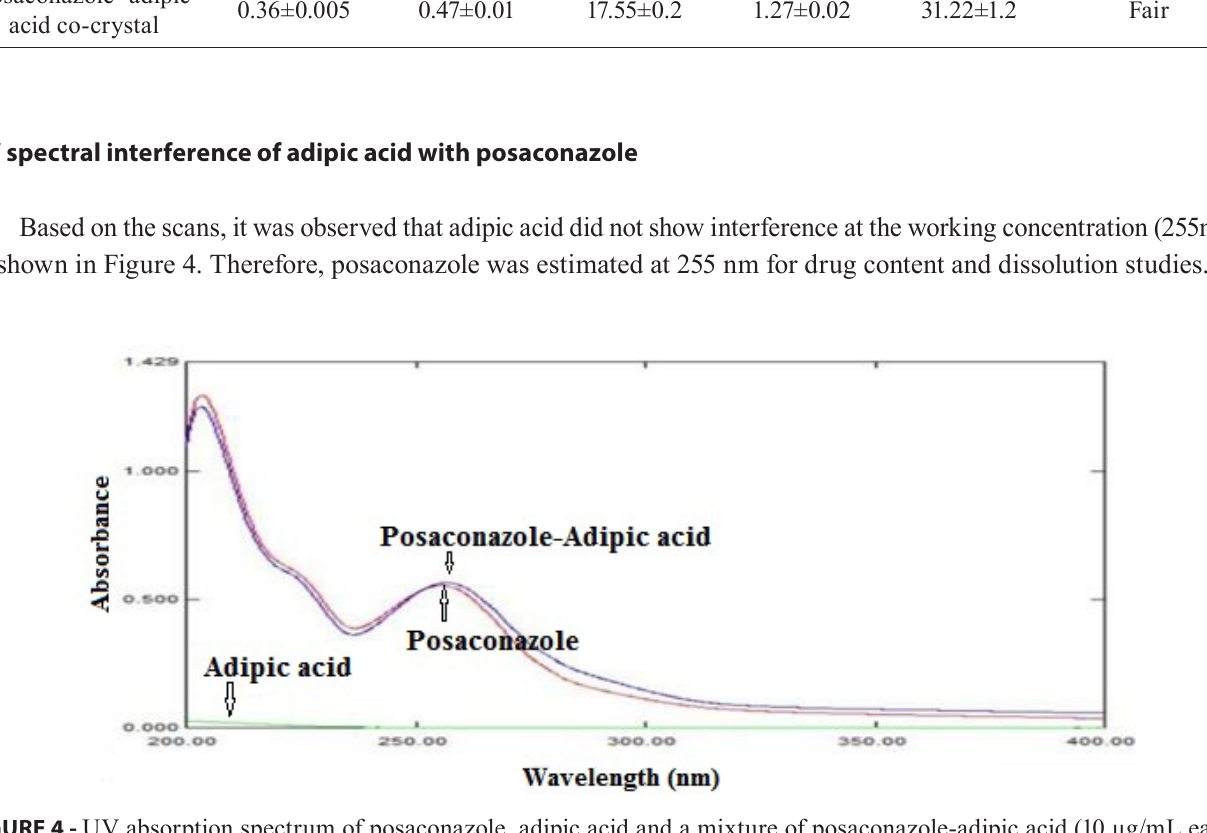
FIGURE 4 - UV absorption spectrum of posaconazole, adipic acid and a mixture of posaconazole-adipic acid (10 µg/mL each) at 255